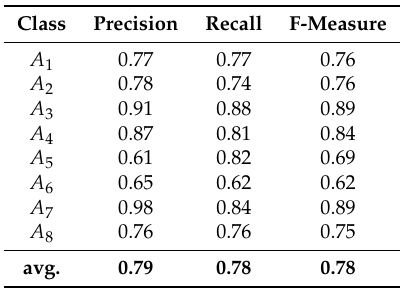
Table 6. Precision, Recall, and F-measure of the proposed model for position-independent and subject-independent